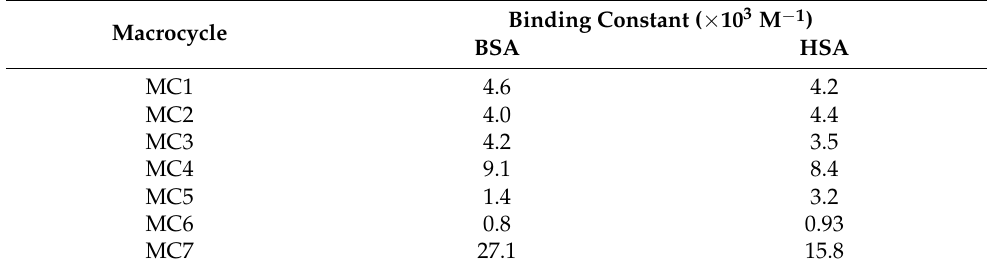
Table 1. The binding constant of the macrocycles with the proteins BSA and